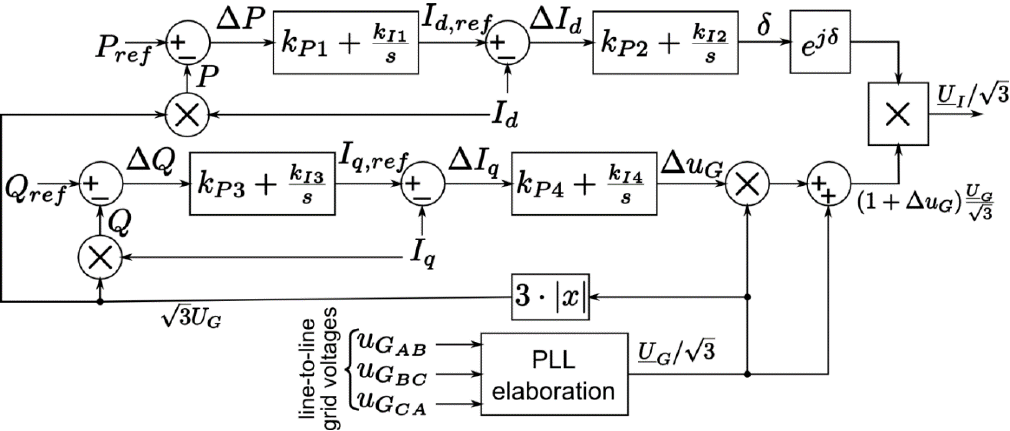
Figure 15. Outline of the P / Q control